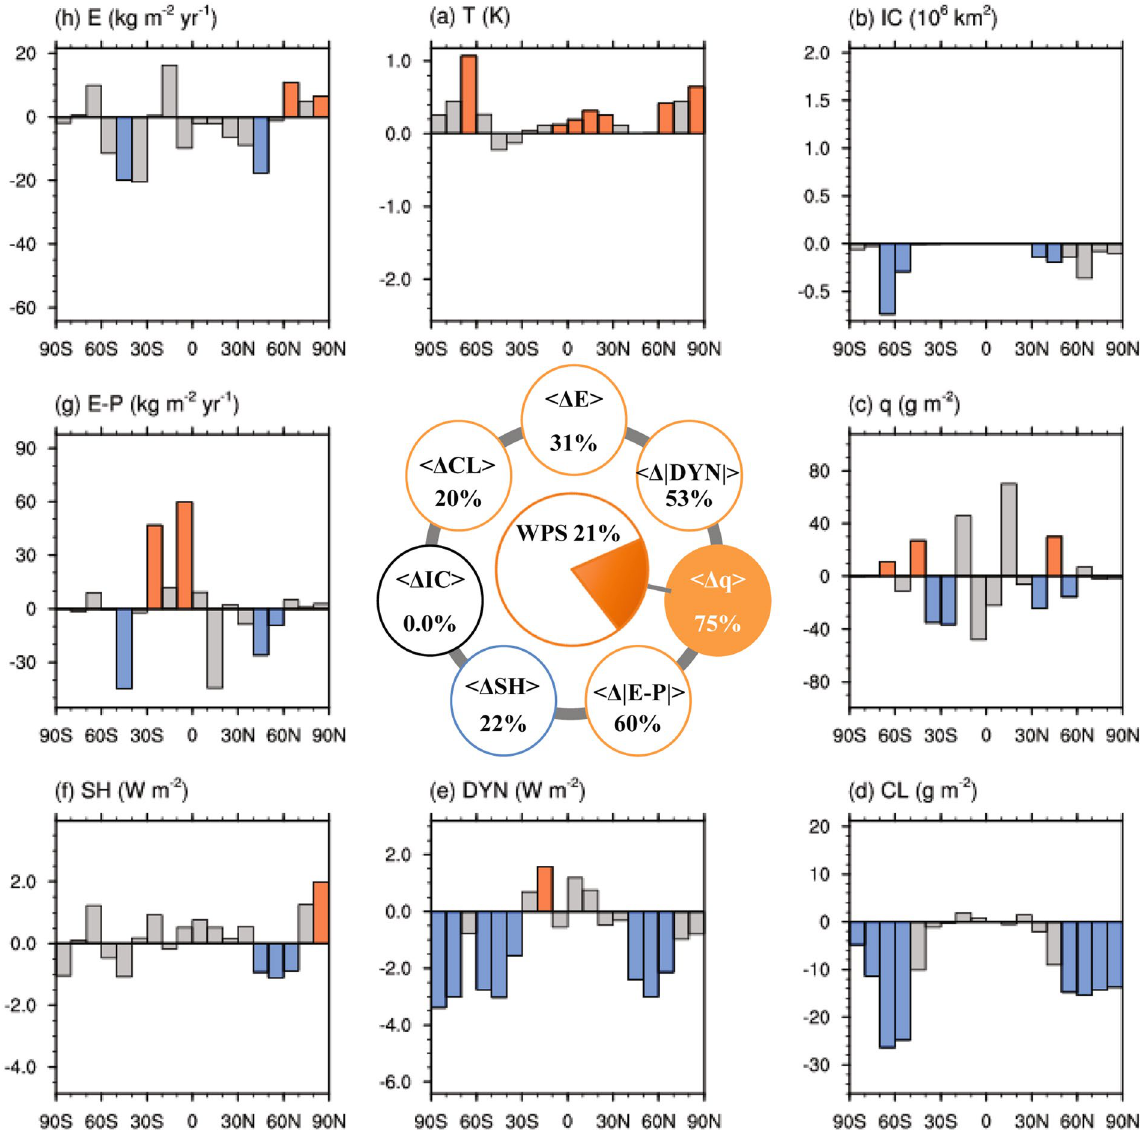
Figure 4. As in Fig. 3 except for the portion of each corresponding variable not correlated with the spread the total ice/snow area coverage response. All correlations are made with the remaining spread (75%) in the total column-integrated atmospheric water vapor response. The numbers inside the inner panel circle still represent the percentage of the spread, in the global mean changes of the eight key climate state variables that can be explained by the remaining portion of the spread in the total column-integrated atmospheric water vapor